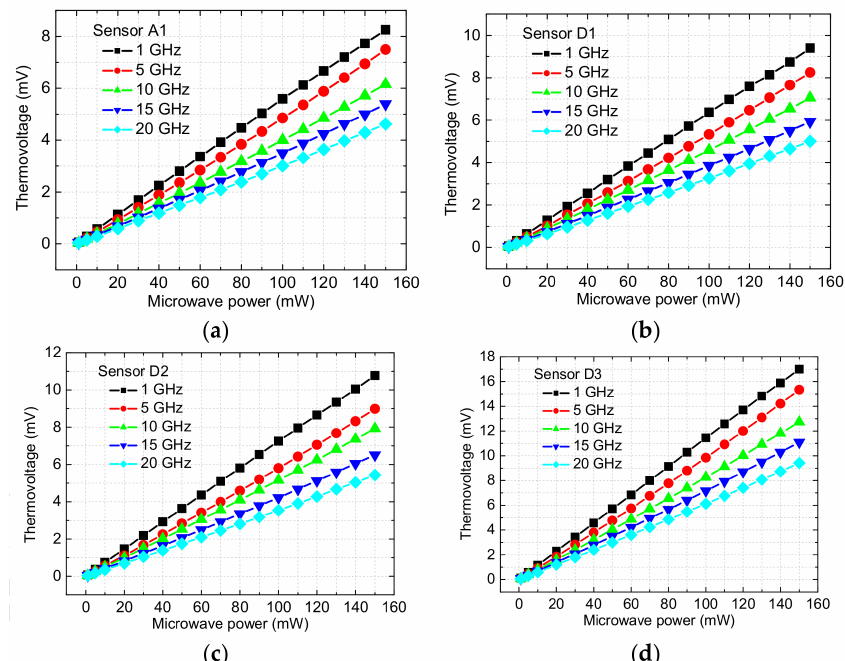
Figure 8. Measured thermovoltage as a function of the microwave power at 1, 5, 10, 15, and 20 GHz for the basic and improved MEMS power sensors. ( a ) Sensor A1 with the basic structure; ( b ) Sensor D1 with with the overlapping length of 2 µ m; ( c ) Sensor D2 with the overlapping length of 10 µ m; and, ( d ) Sensor D3 with the floating thermal slug and the back